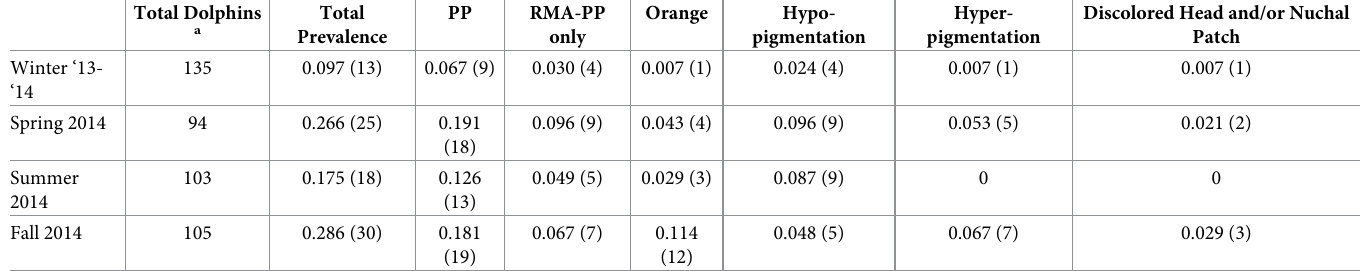
Table 2. Prevalence (with sample size in parentheses) of skin lesions seen on dolphins found in the Pensacola Bay system over time and by